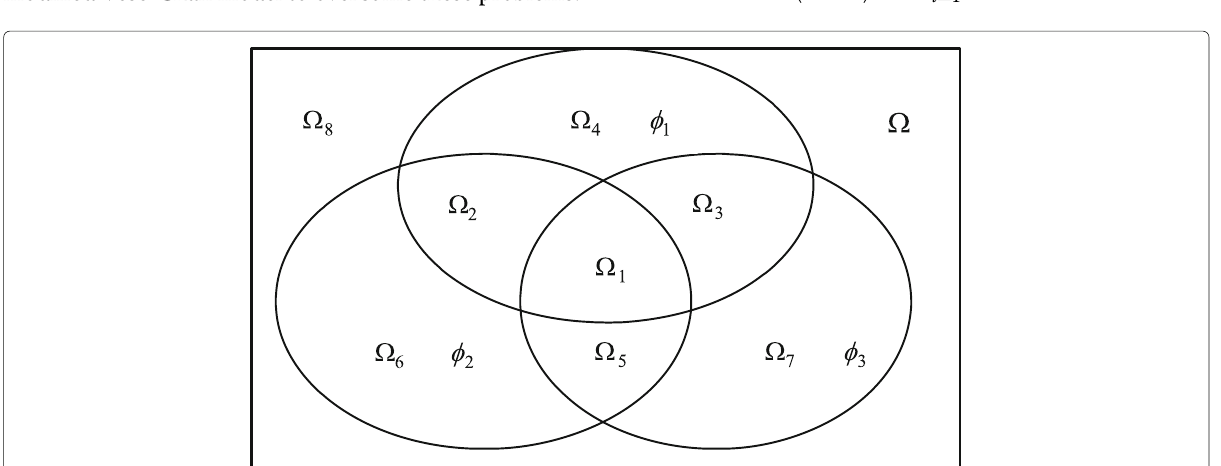
Fig. 1 Eight regions partitioned by three binary label